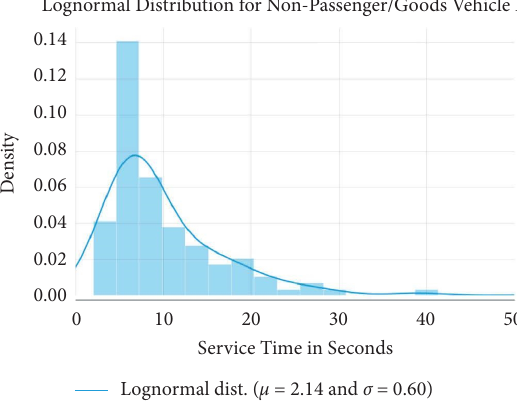
Figure 5: Lognormal distribution for diferent vehicle classes of lane 1#